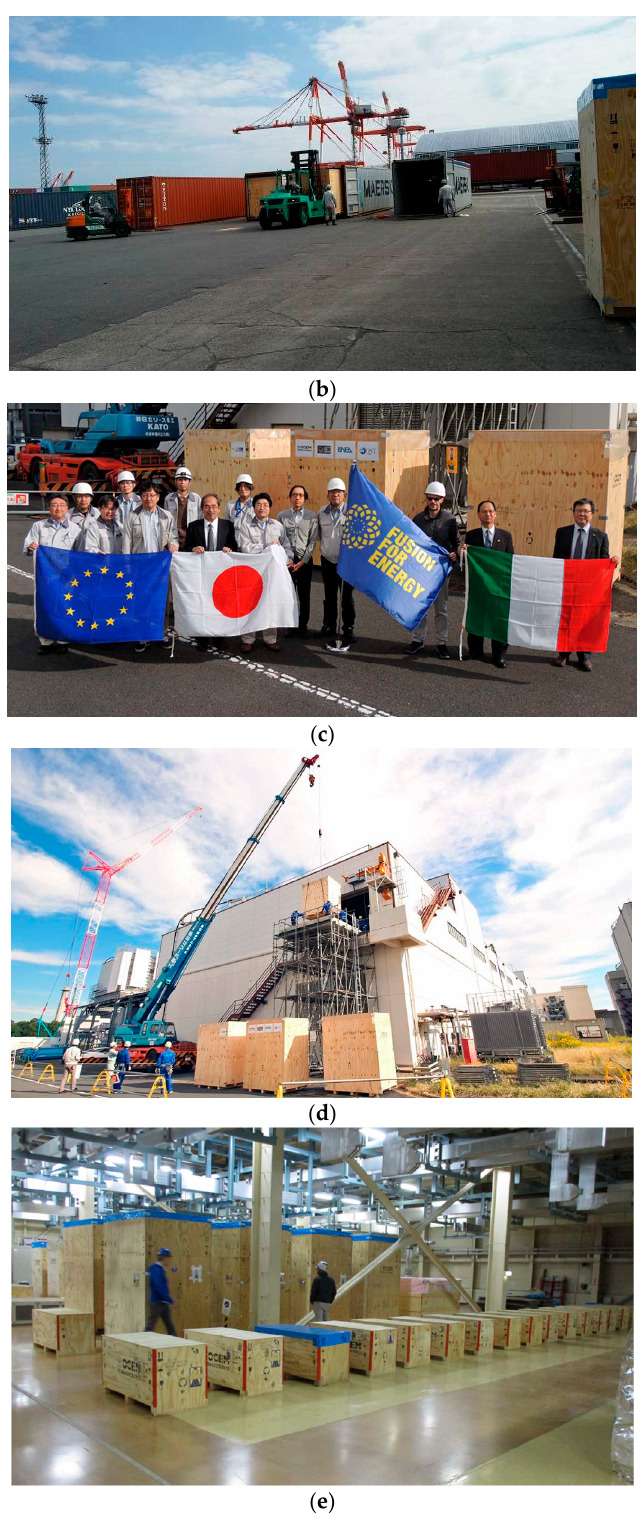
Figure 4. Pictures taken during the activities for the JT-60SA CS SNU procurement: ( a ) The 52 wooden crates ready for shipment in OCEM premises before leaving to Japan; ( b ) Wooden crates moved from the containers for the inspection at the Yokohama port (Japan); ( c ) Group photo in front of the SNU crates just arrived at the JT-60SA Naka site; ( d ) Lifting the crates into the second floor of the JT-60SA Rectifier Building where they will be installed; ( e ) The SNU components finally ready for installation in the JT-60SA Rectifier Room in Naka.